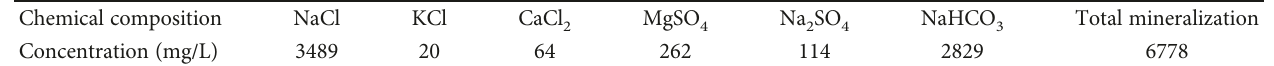
Table 1: Composition of the injection and the formation